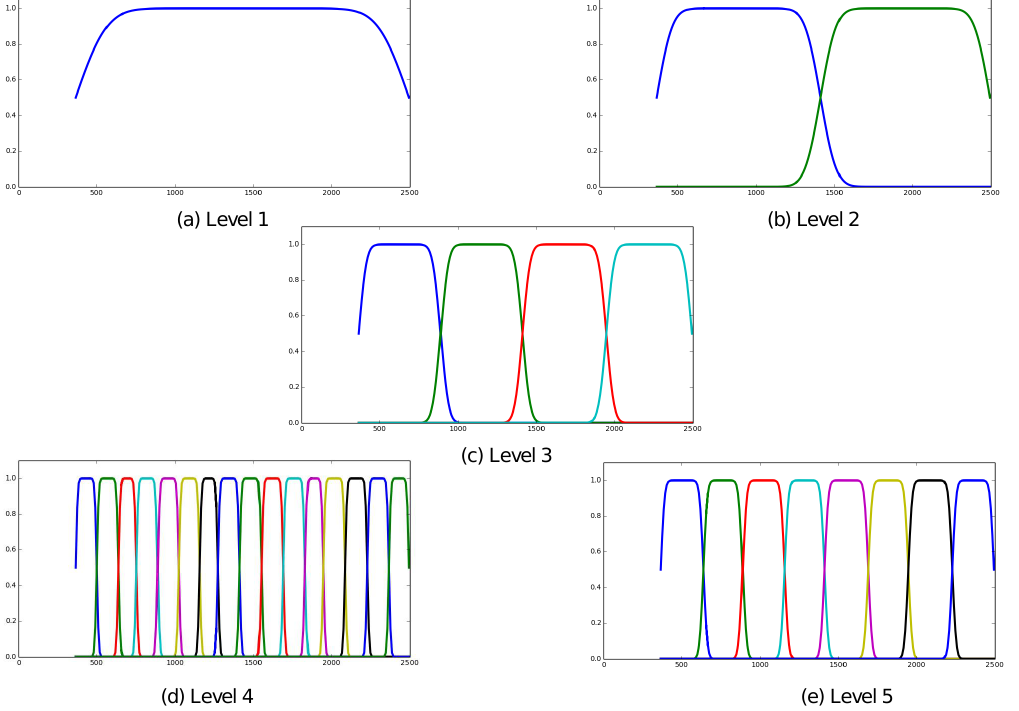
Figure 3. Different levels of Spectral Sensitivity Functions